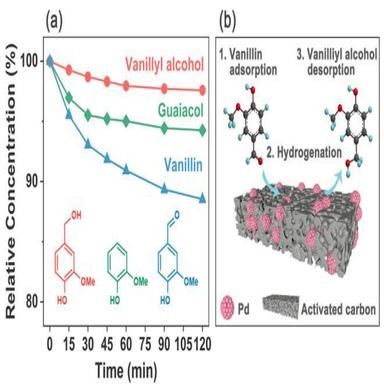
Hydrogenation mechanism of Pd/C (a. Adsorption performance of Pd/ C; b. Schematic diagram for hydrogenation of vanillin).